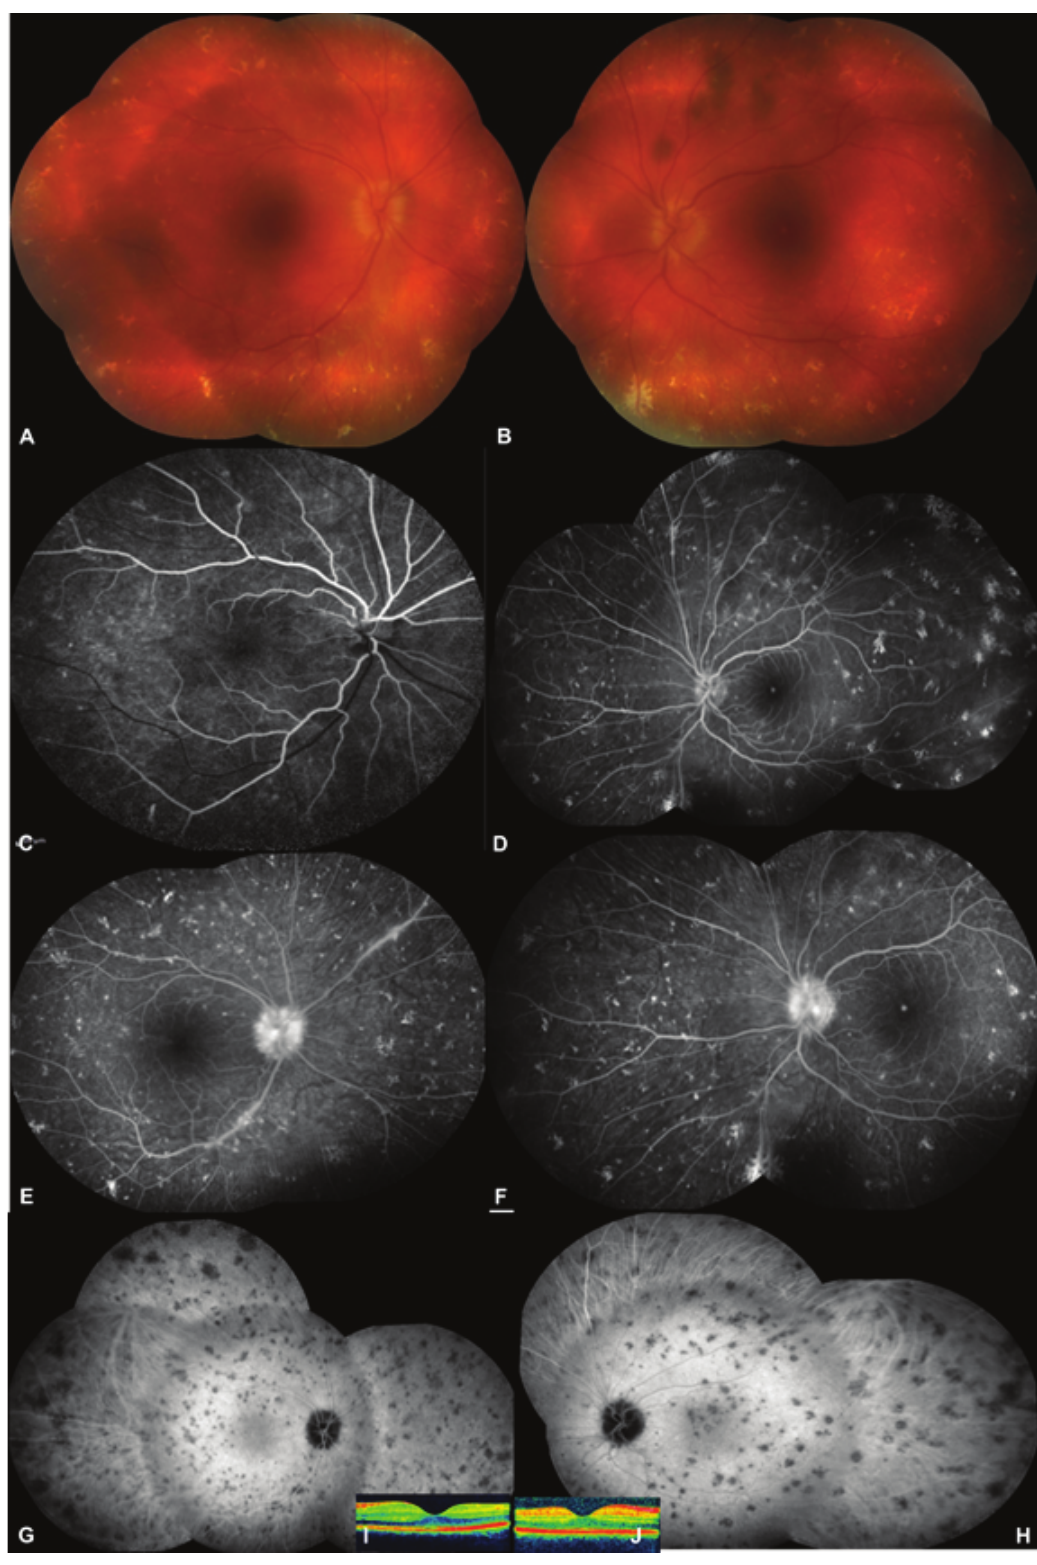
Figure 1. Composite of color fundus showing 360° scattered yellowish–gray spot like aggregates, (A) right eye, (B) left eye. Early venous phase of composite fluorescein angiographic picture exhibiting staining of these spot-like lesions, (C) right eye, (D) left eye. Late venous phase of composite fluorescein angiographic picture showing leakage from the optic disc, (E) (right eye), (F) left eye. Mid-phase of composite indocyanine green picture demonstrating the hypocyanescent widespread spot-like opacities, (G) right eye, (H) left eye. Normal foveal contour on optical coherence tomography, (I) right eye, (J) left